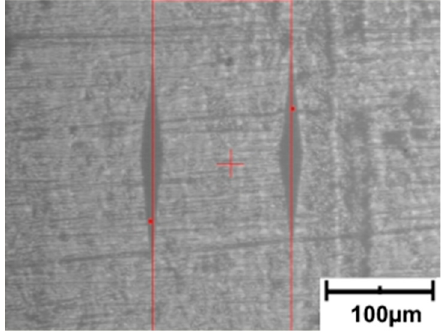
Figure 4. Microscopic image used to determine the distance between the imprints.